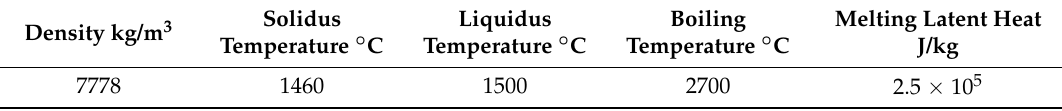
Figure 6. The material physical properties vary with temperature: ( a ) Thermal conductivity coefficient; ( b ) specific heat. Table 2. The physical properties parameters of the base material.